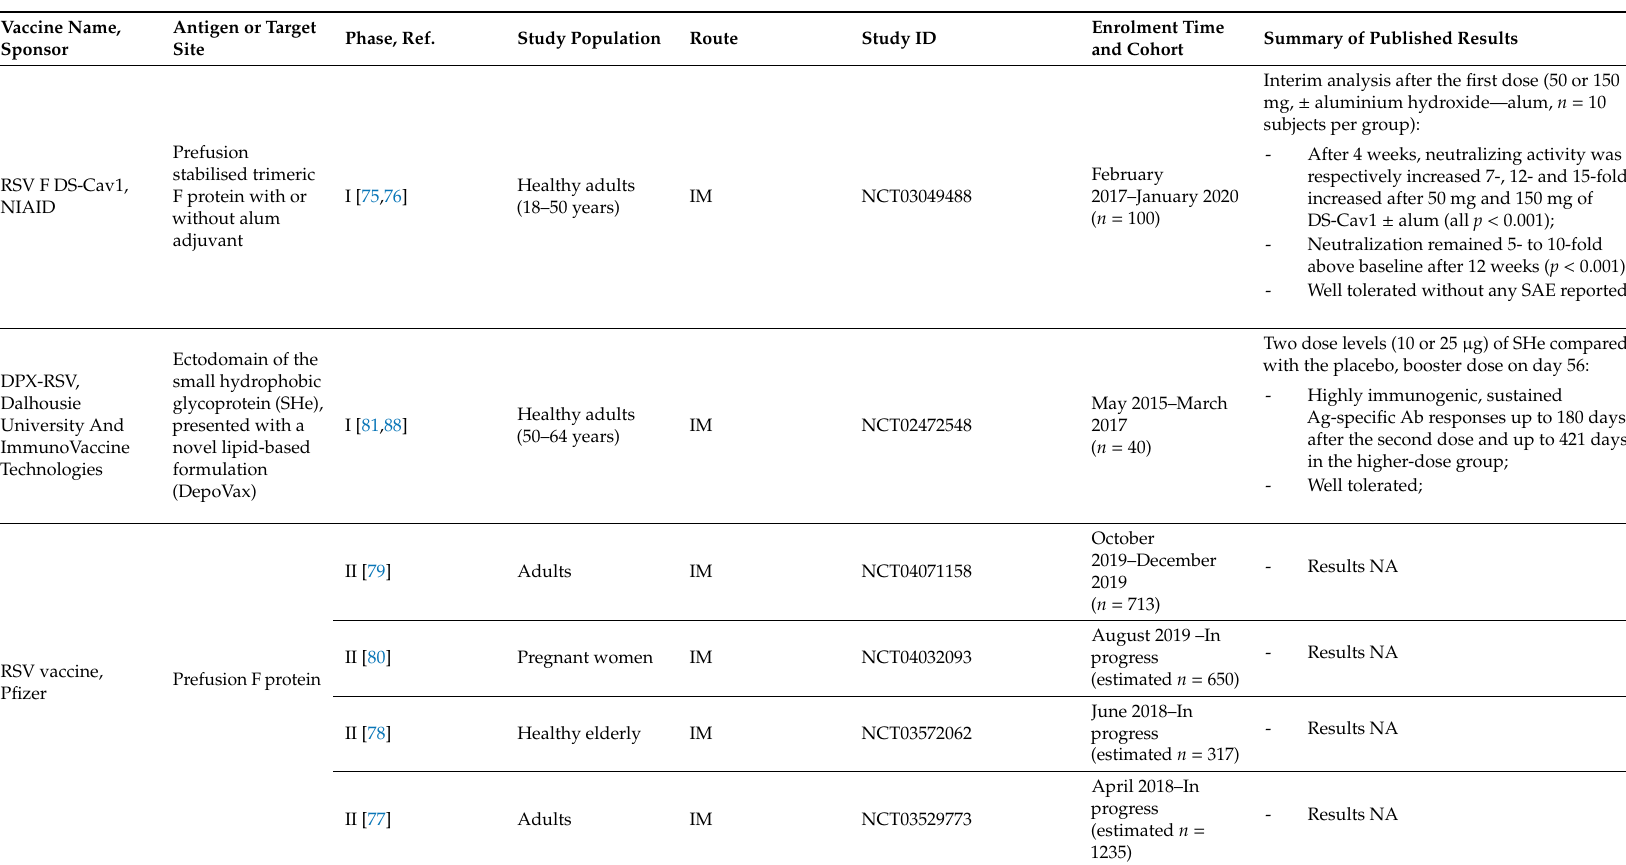
Table 4. Overview of the RSV subunit vaccines in clinical development. Ab: antibody; ADA: anti-drug antibody; AE: adverse event; Ag: antigen; CI: confidence interval; CHD: congenital heart defect, CLD: chronic lung disease; COPD: chronic obstructive pulmonary disease; Corp: corporation; f.up: follow-up; GA: gestational age; IM: intramuscular; IN: intranasal; IV: intravenous; LRTD: lower respiratory tract disease; LRTI: lower respiratory tract infection; mAb: monoclonal antibody; NA: not available; NIAID: National Institute of Allergy and Infectious Diseases; PCA: palivizumab-competing antibody; PIV3: Parainfluenza Virus type 3; Ref: reference; RSV: respiratory syncytial virus; RT-PCR: reverse transcriptase polymerase chain reaction; SAE: serious adverse event; TCID 50 : Tissue Culture Infectious Dose 50%; vs.: